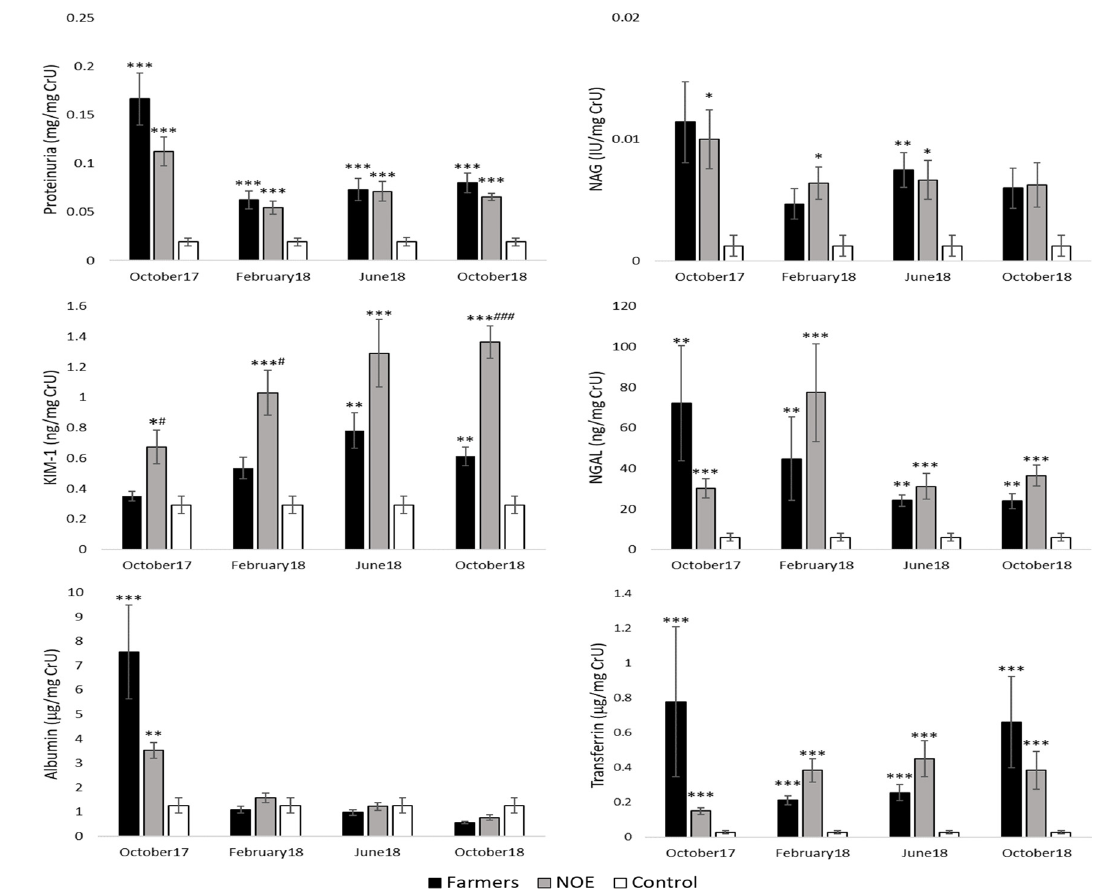
Figure 3. Urinary levels of the biomarkers of early kidney damage evaluated at different sampling times. Data are expressed as the mean ± SEM. * p < 0.05; ** p < 0.01; *** p < 0.001 versus control group. # p < 0.05; ### p < 0.001 versus farmers group. CrU: urinary creatinine; KIM-1: kidney injury molecule 1; NAG: N-acetyl- β -D-glucosaminidase; NGAL: neutrophil gelatinase-associated lipocalin; NOE: non-occupational exposed.